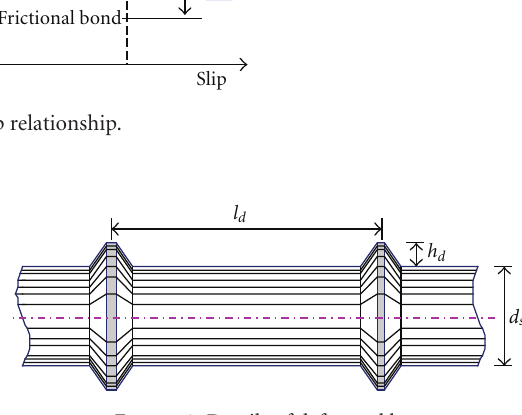
Figure 2: Details of deformed